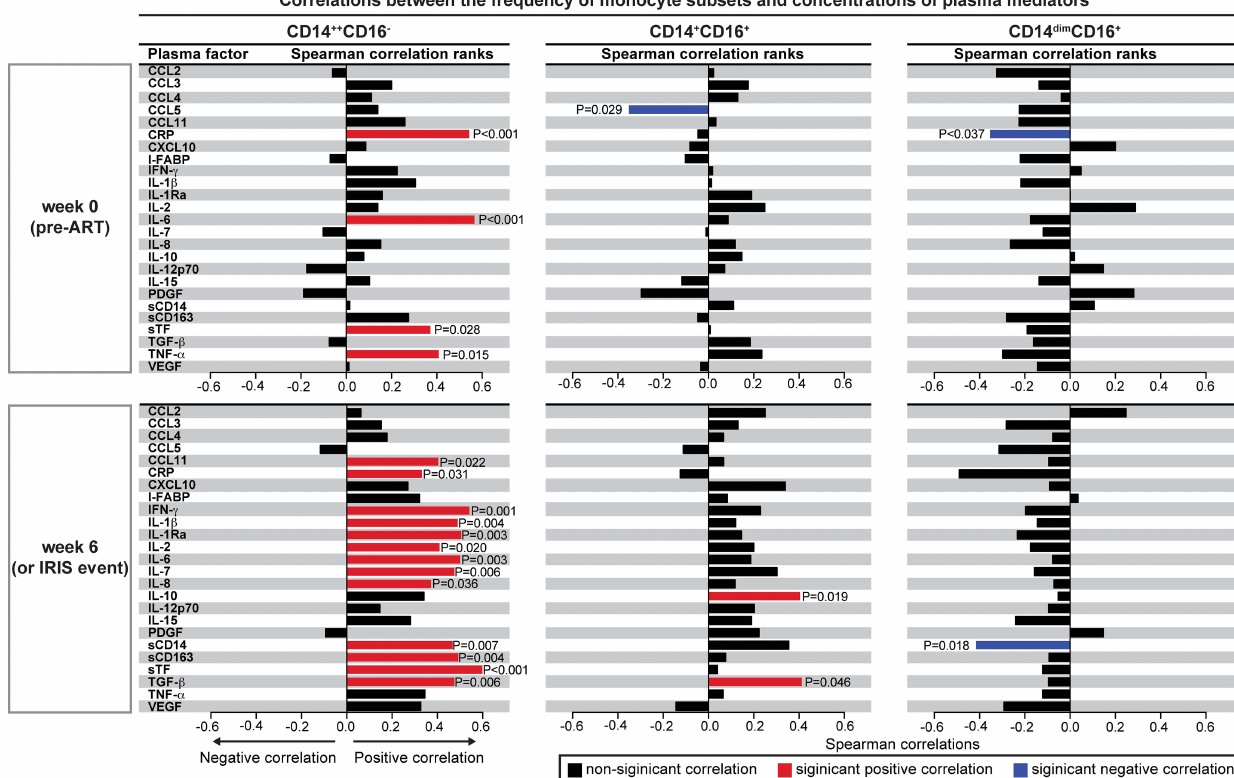
Figure 6. The CD14 ++ CD16 2 monocyte subset strongly correlates with pro-inflammatory biomarkers in TB-HIV co-infected individuals upon ART initiation. Percentage of circulating CD14 ++ CD16 2 (left), CD14 + CD16 + (center) and CD14 dim CD16 + (right) monocytes among circulating mononuclear myeloid cells were tested for correlations with several pro-inflammatory cytokines and chemokines at week 0 (pre- ART) and at week 6 or at the time of IRIS after ART initiation in the entire study population (n=48). Bars represent the strength of associations (r values), and P-values of statistically significant results are displayed.